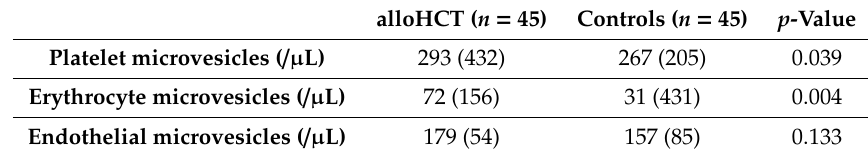
Table 3. Novel markers of endothelial dysfunction and thrombotic tendency in alloHCT survivors and matched controls. alloHCT ( n = 45) Controls ( n =